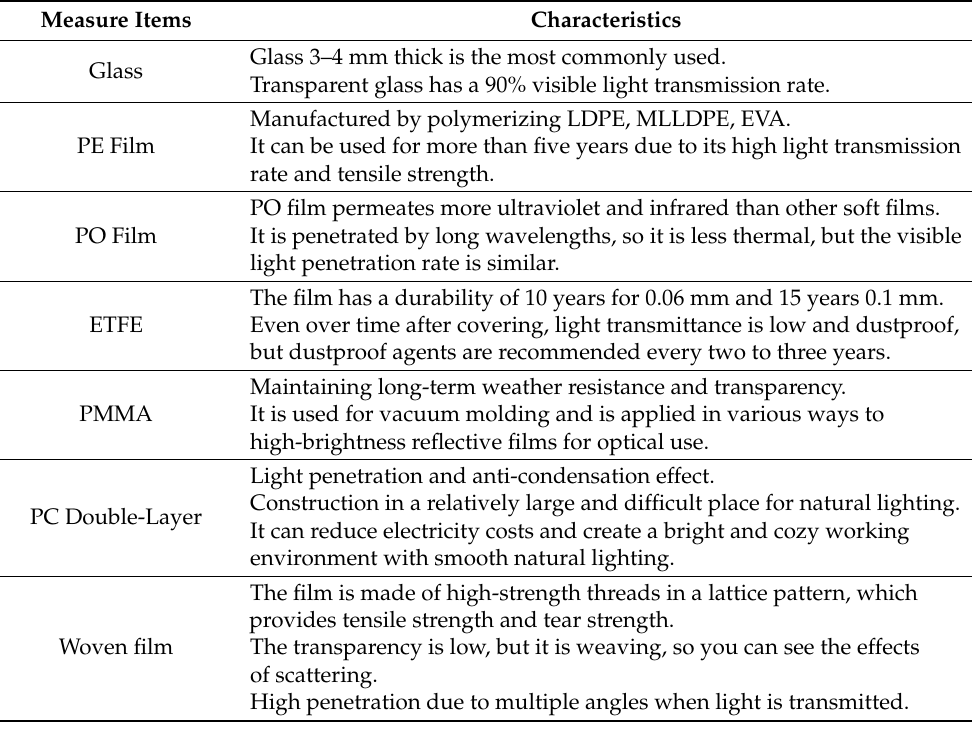
Table 1. Measurement items and characteristics.